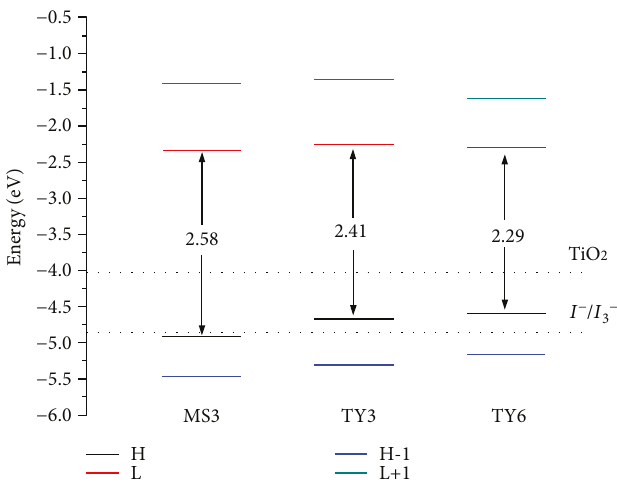
Figure 2: Frontier molecular orbital energies and energy gaps of MS3, TY3, and TY6. Table 3: Calculated transition energies and oscillator strengths of MS3, TY3, and TY6.